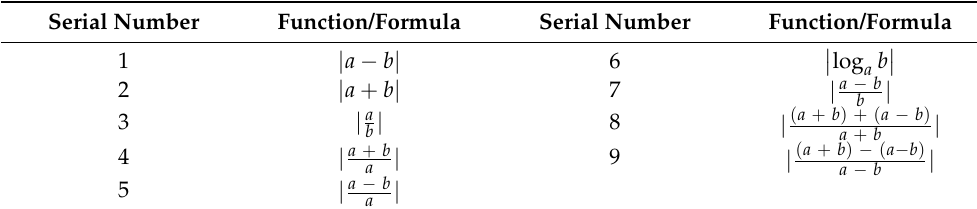
Table 2. List of the formulas used to verify the significance between the multiple wavelengths.